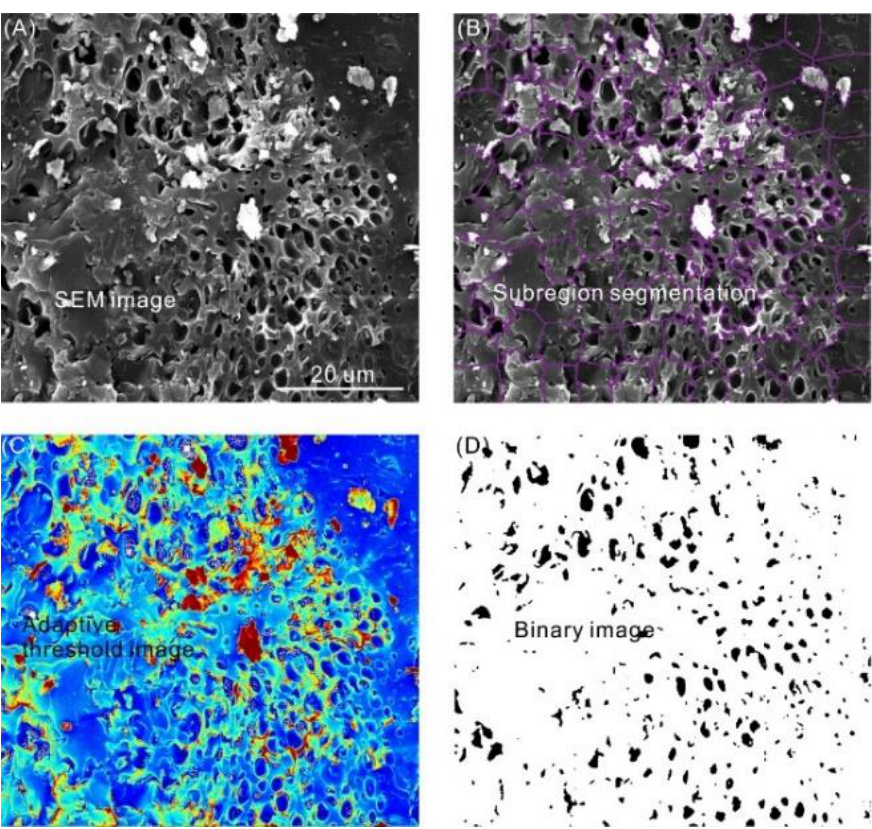
Figure 3. The binarization process of a SEM image: ( A ) WZ3-3, 232 m, matrix micropores; ( B ) Sub- region segmentation of ( A ); ( C ) Adaptive threshold image of ( A ); ( D ) Binary image of ( A